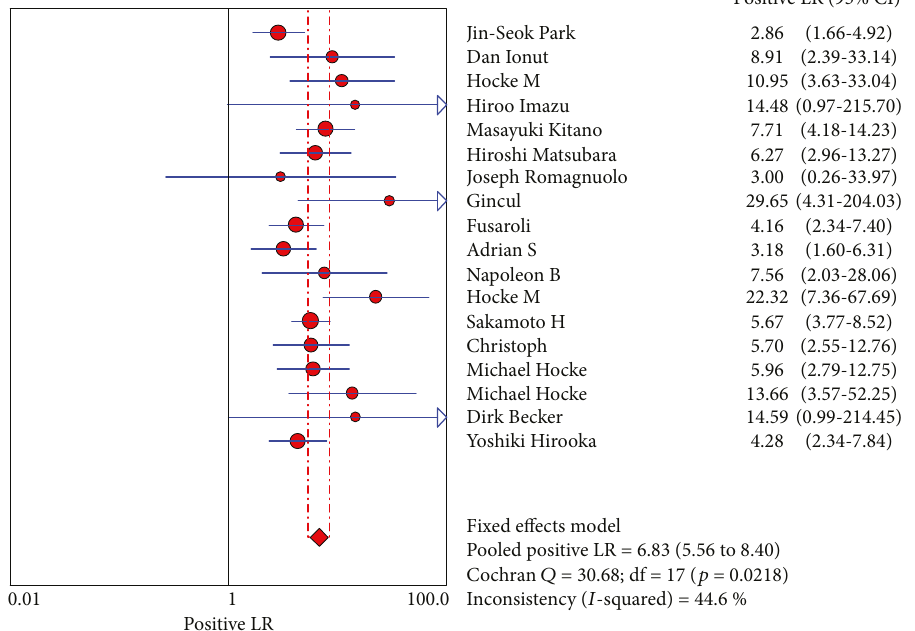
Figure 5: Positive LR of the selected studies and this meta.